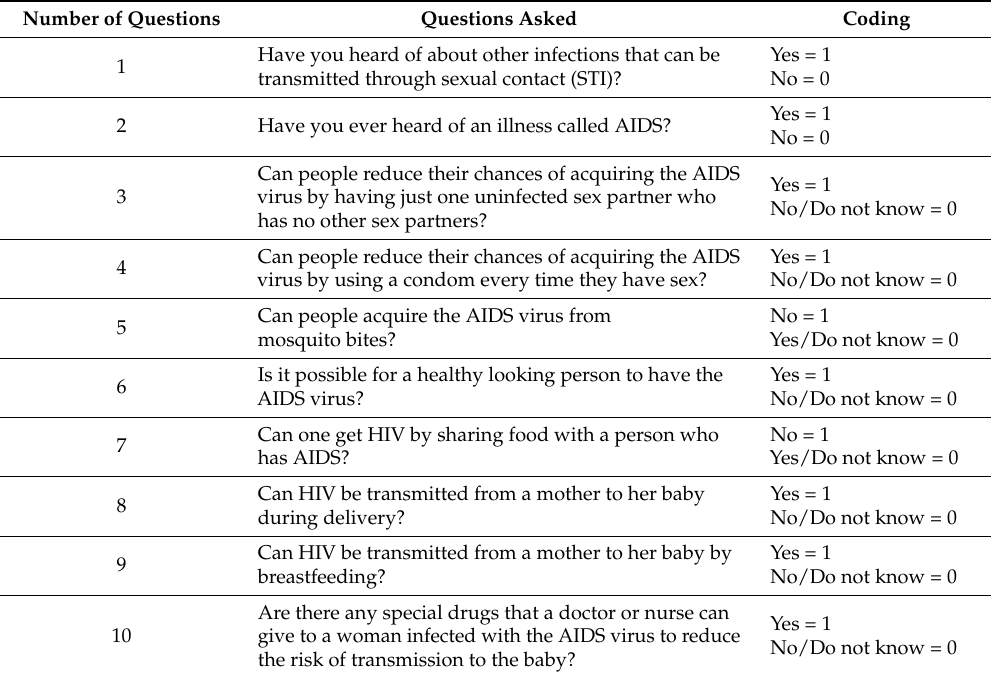
Table A1. Assessment of HIV